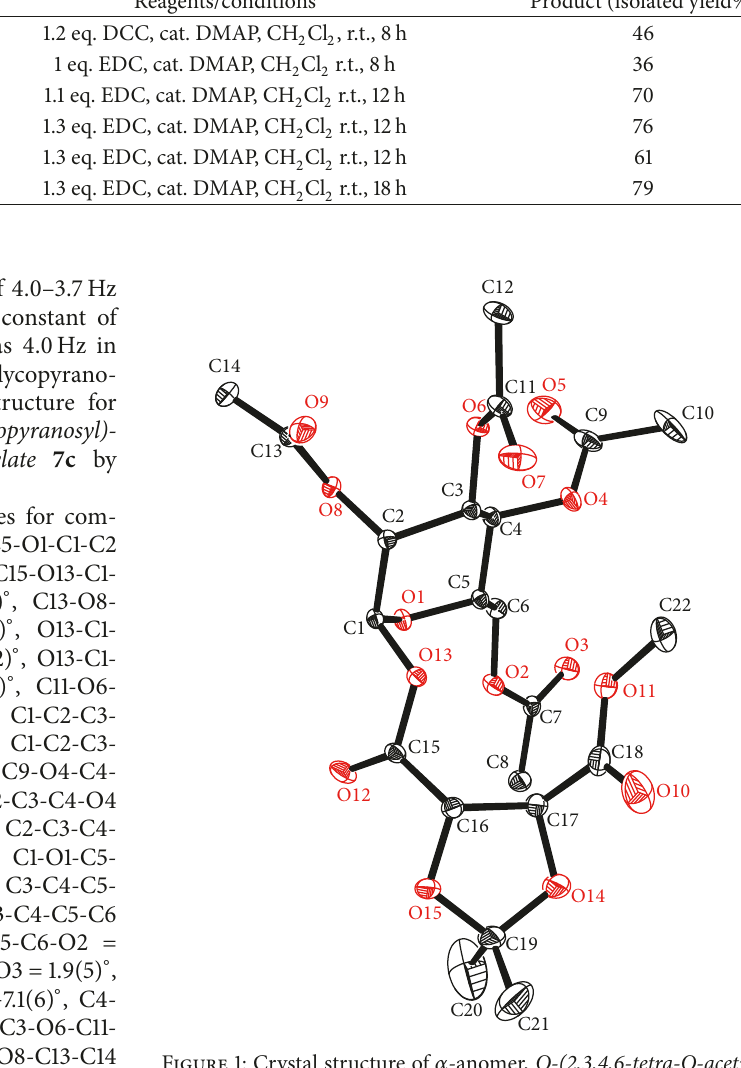
Figure 1: Crystal structure of 𝛼 -anomer, O-(2,3,4,6-tetra-O-acetyl- 𝛼 -D-mannopyranosyl)-(4R,5R)-2,2-dimethyl-1,3-dioxolane-4,5- dicarboxylate 7c